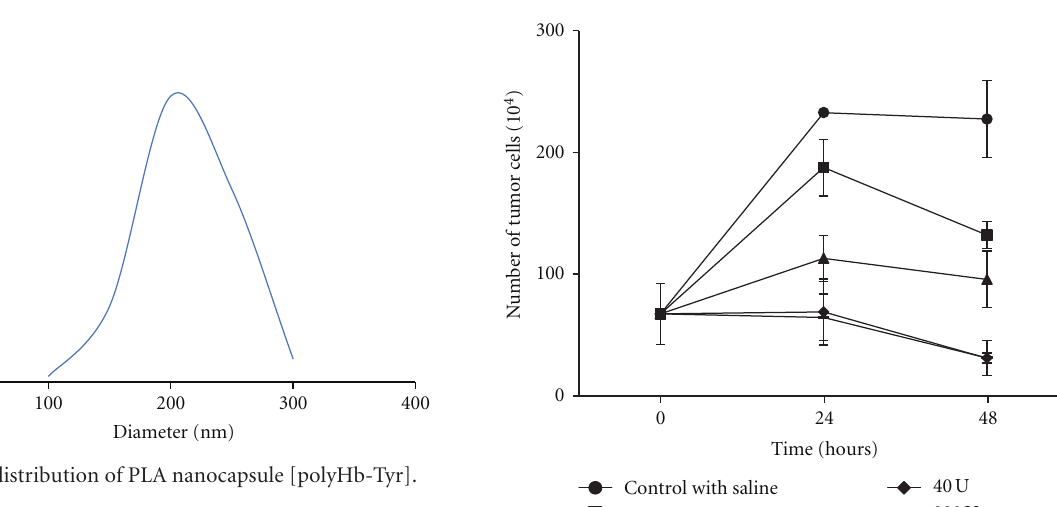
discarded. The fraction of > 100 kDa (88.5% of the samples) was used for nanoencapsulation. The encapsulation e ffi ciency was 75.4% (Figure 4).